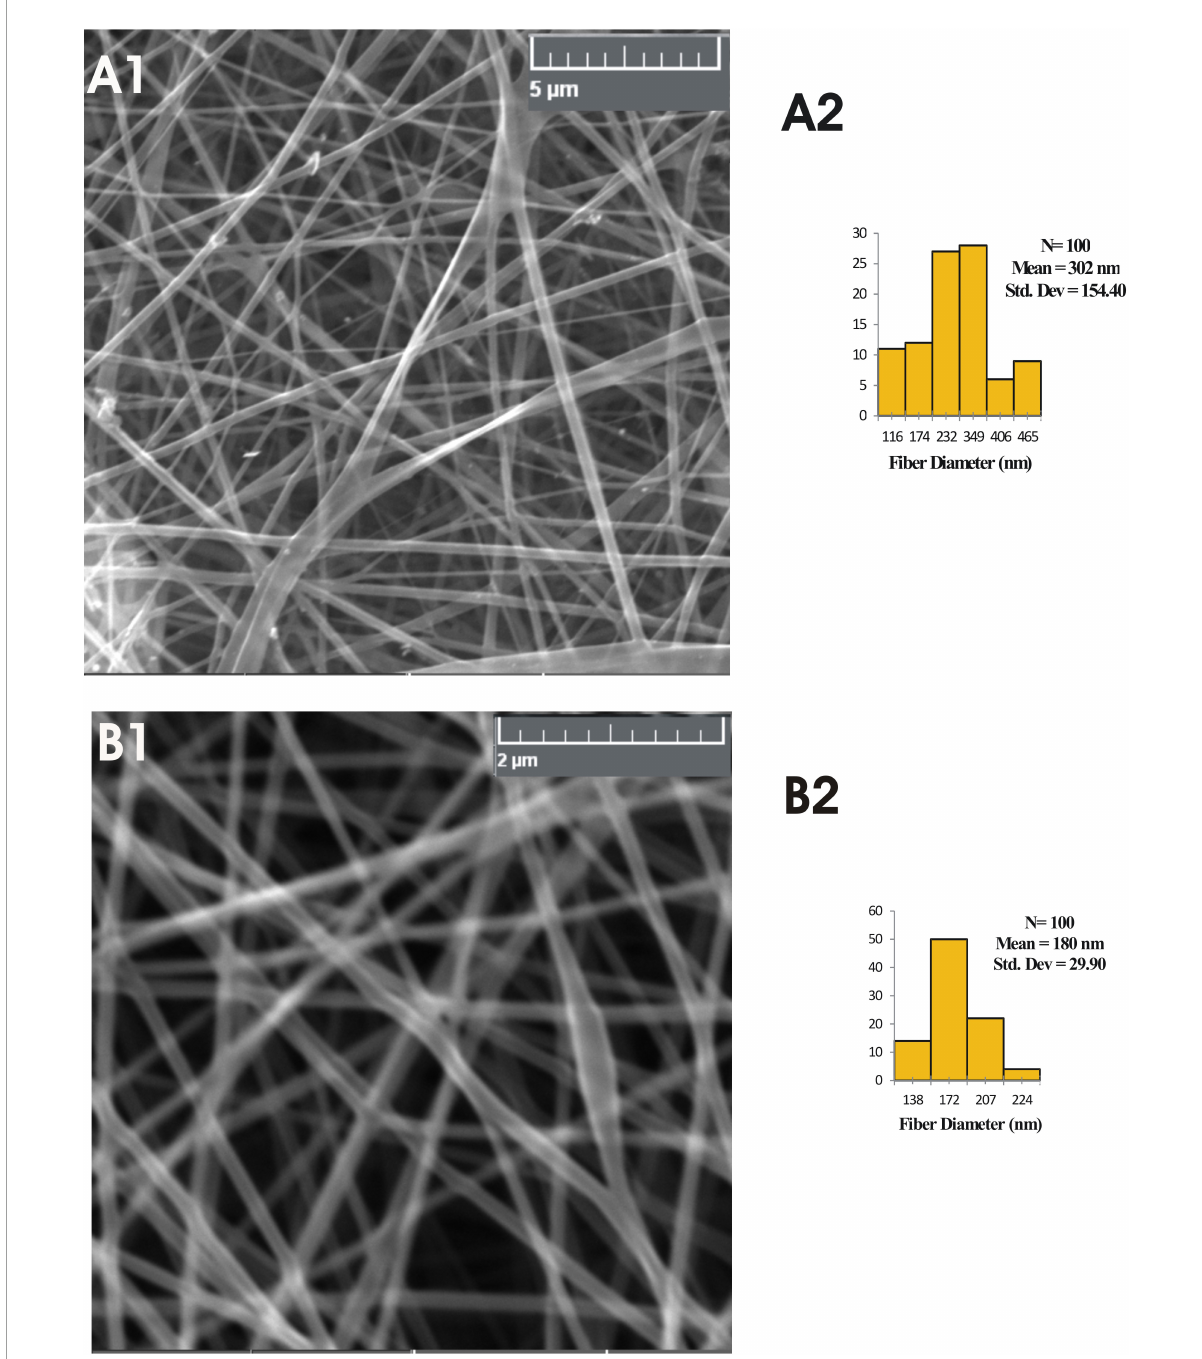
FIGURE1 Scanning electron microscopic images (A1,B1) and diameter distribution histograms (A2,B2) of the composite nanofiber mats 4 and 5.